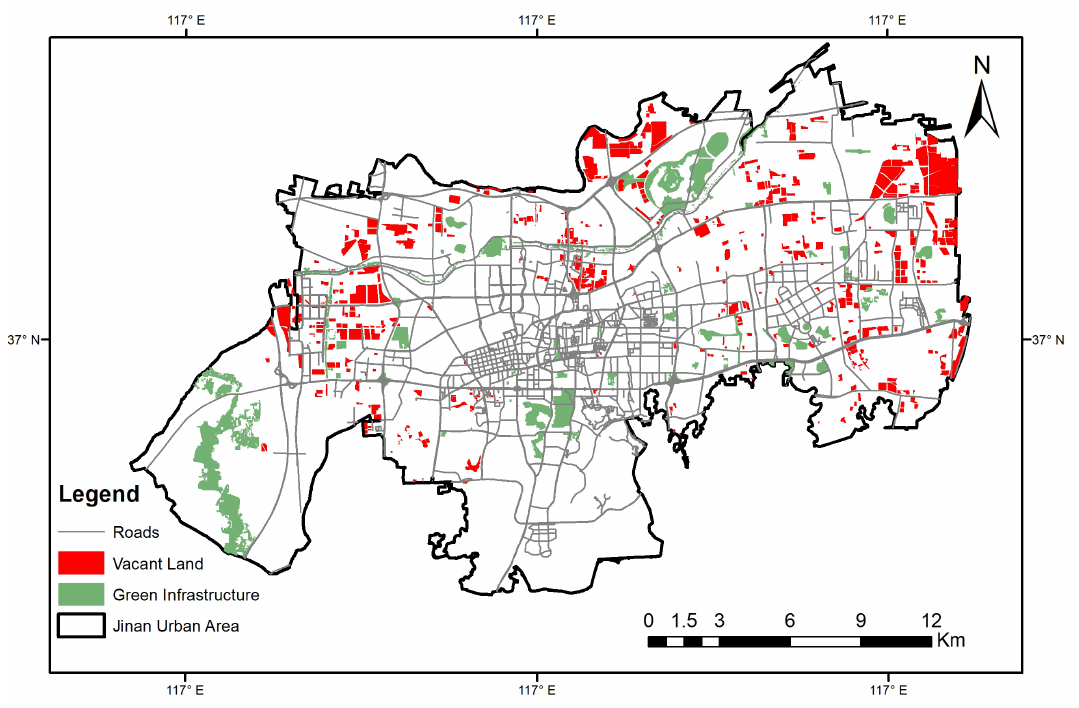
Figure 6. Map of GI and vacant land in